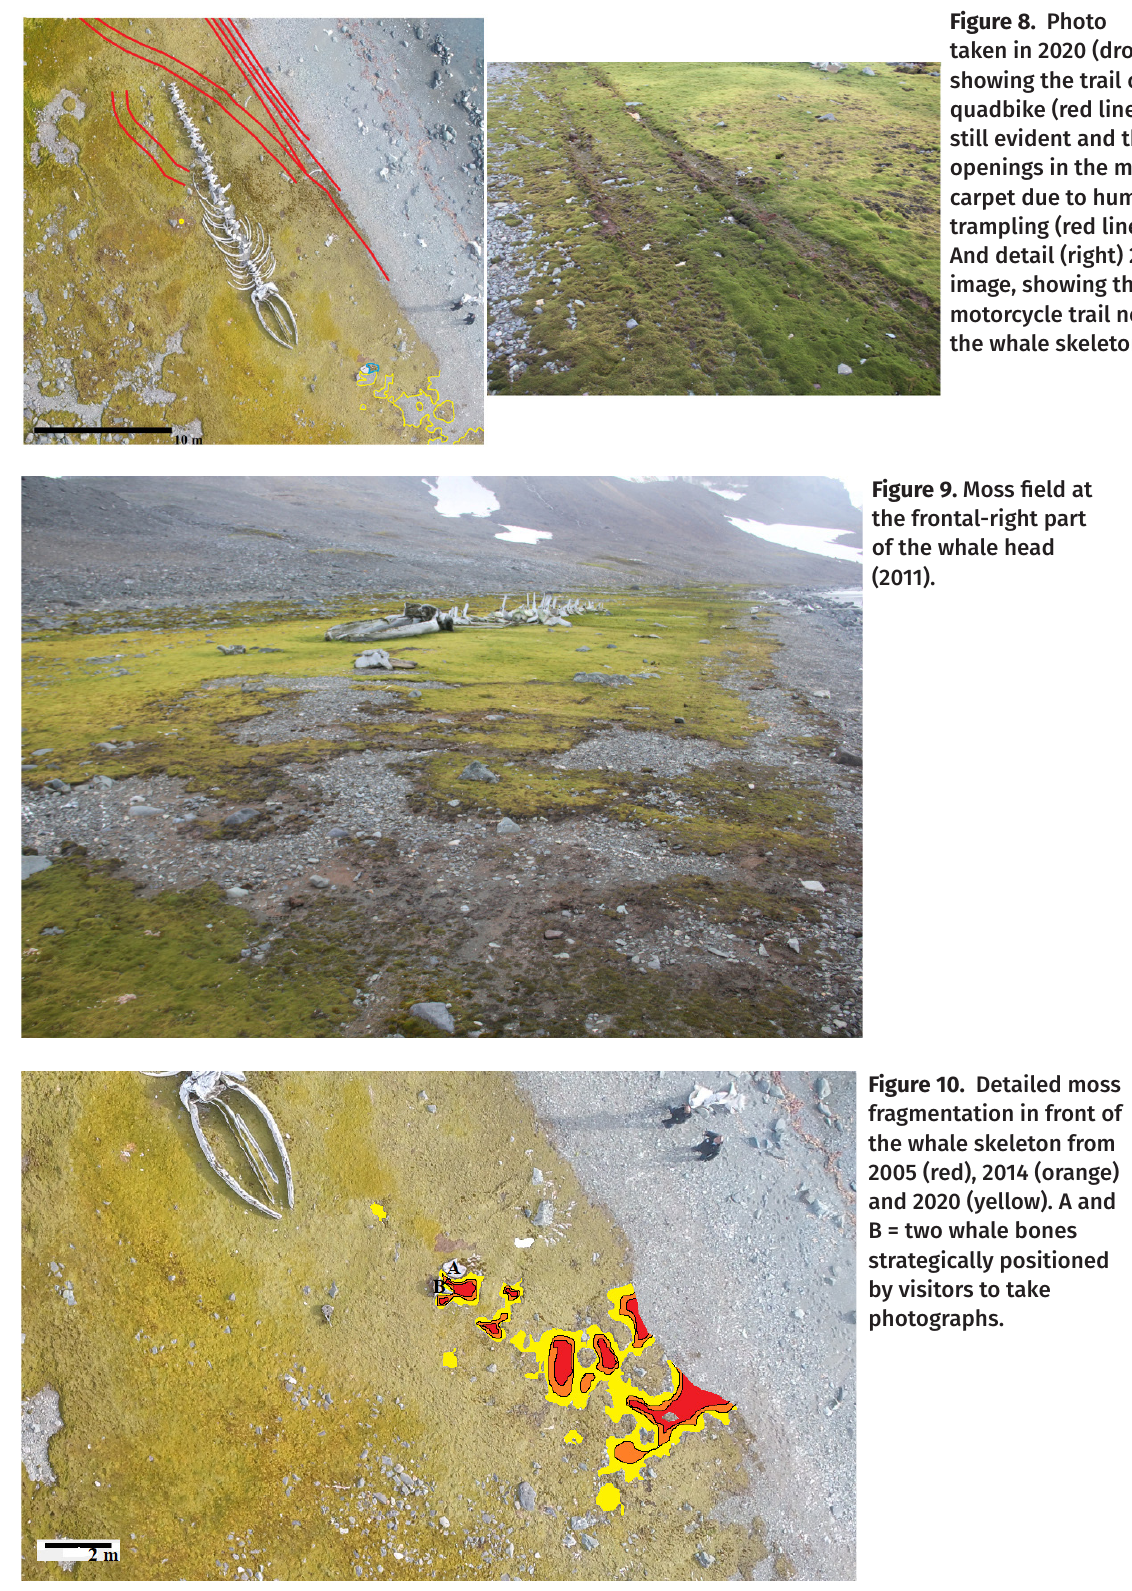
Figure 8. Photo taken in 2020 (drone) showing the trail of the quadbike (red lines) still evident and the openings in the moss carpet due to human trampling (red line). And detail (right) 2011 image, showing the motorcycle trail near the whale skeleton.